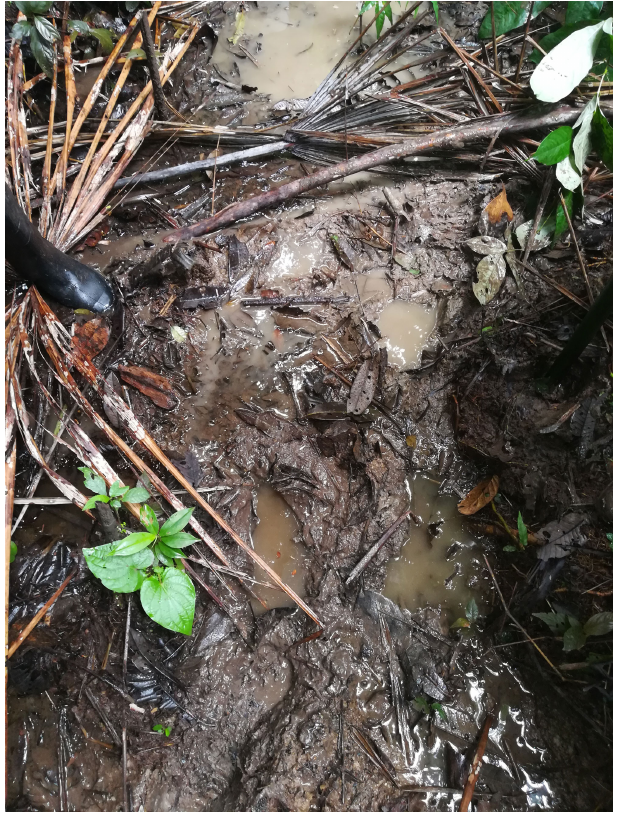
Fig. 4 . The ground in an elelia . This ecosystem consists of mostly dryland forest dominated by the Attalea butyracea palm species; standing water does exist but is much rarer than in the alaka ecosystem.